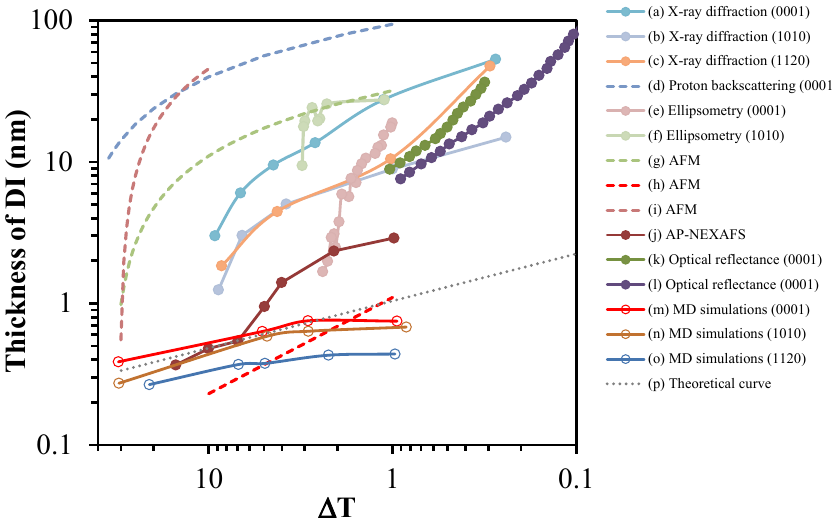
Fig. 7. Comparison of different methods to derive the thickness of the disordered interface (DI) at the free ice surface versus 1T = T m − T obtained using different methods. Solid circles are measured data, while dashed lines are results from reported equations fit to experimental data. Molecular dynamics (MD) simulations are represented by open circles. Glancing-angle X-ray diffraction (Dosch et al., 1995) on (a) basal and (b, c) prismatic crystal surfaces, (d) proton backscattering (Golecki and Jaccard, 1978) on basal ice, ellipsometry (Furukawa and Nada, 1997) on (e) basal and (f) prismatic crystal surfaces, (g) atomic force microscopy (AFM) (Döppenschmidt and Butt, 2000) on a 100ml frozen droplet and vapour deposited on mica, (h) AFM (Pittenger et al., 2001) for vapour-deposited ice on metal, (i) AFM (Goertz et al., 2009) for ice frozen on a metal substrate, (j) ambient pressure near-edge X-ray absorption fine structure (Bluhm et al., 2002) for vapour- deposited ice on metal, HeNe laser optical reflectance (Elbaum et al., 1993) on basal crystals in the presence of (k) water vapour and (l) 30Torr air, TIP4P/Ice MD simulations (Conde et al., 2008) for (m) basal and (n, o) prismatic crystals, (p) general thermodynamic solution (Dash et al.,